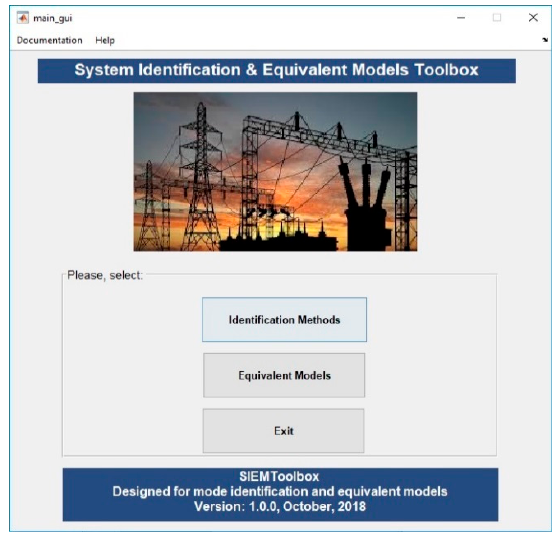
Figure 3. Main window of SIEMToolbox.